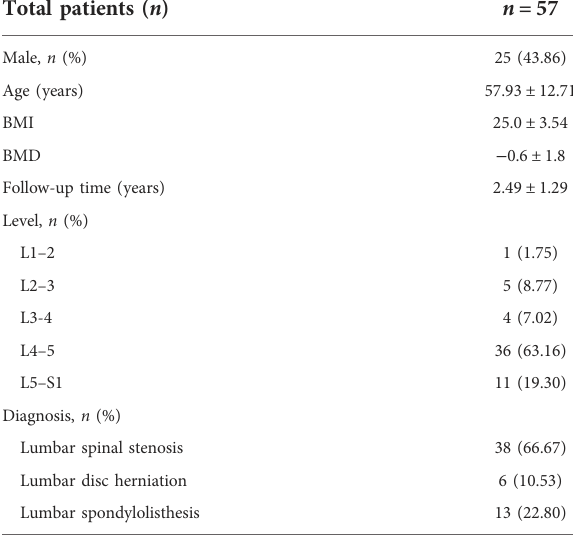
TABLE 1 Characteristics of